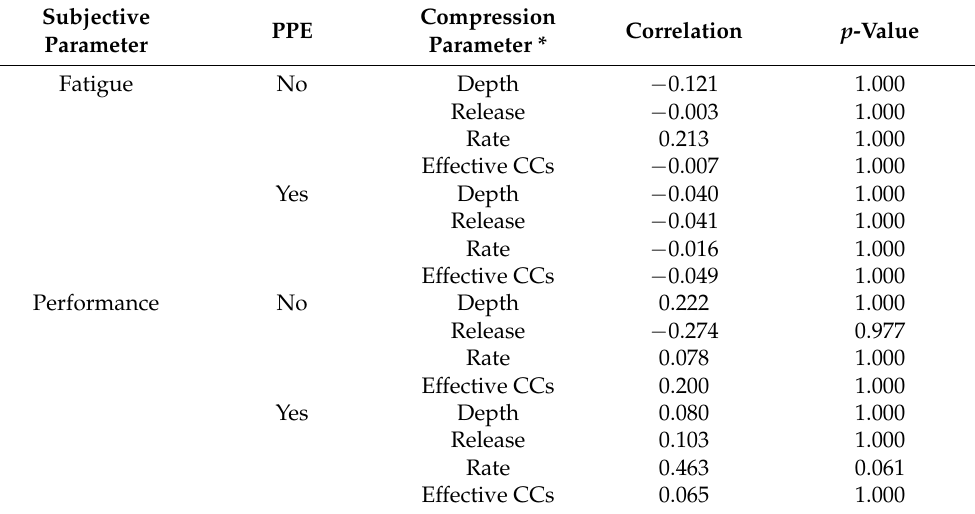
Table 4. The correlation between subjective fatigue and performance of chest compressions and compression parameters. Subjective fatigue and performance are evaluated using an eleven point numeric rating scale (0–10). The p -values are corrected by means of the Holm–Bonferroni